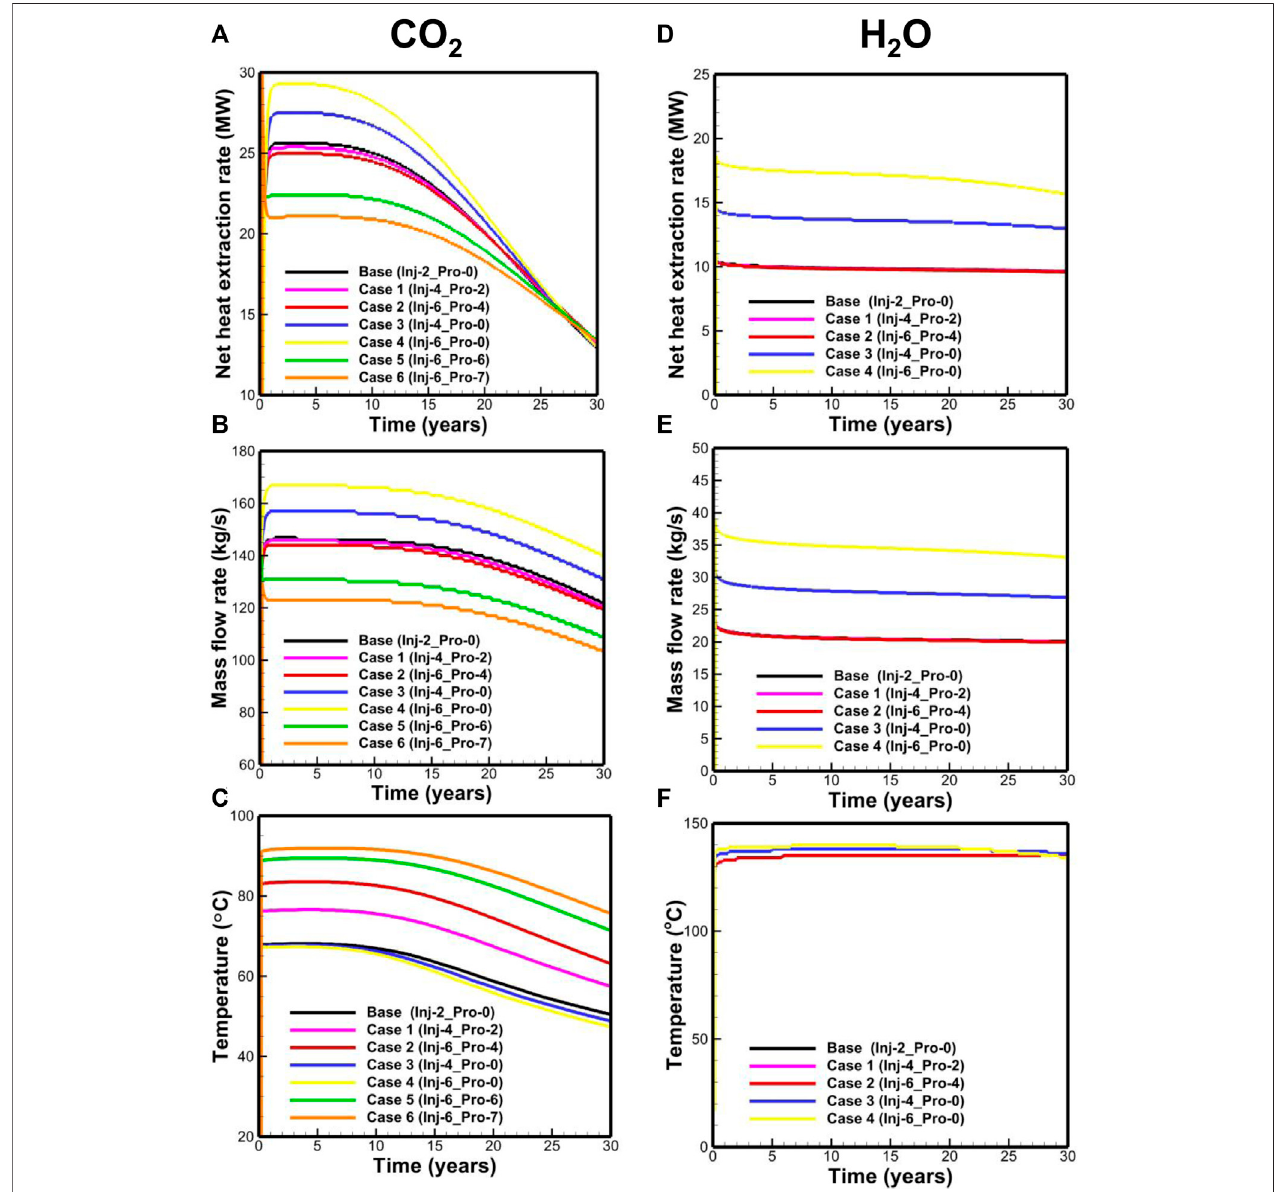
FIGURE 10 | Performance of (A) net heat extraction rate, (B) mass- fl ow rate, (C) temperature for the CO 2 -based EGS, (D) net heat extraction rate, (E) mass- fl ow rate, and (F) temperature for the H 2 O-based EGS.